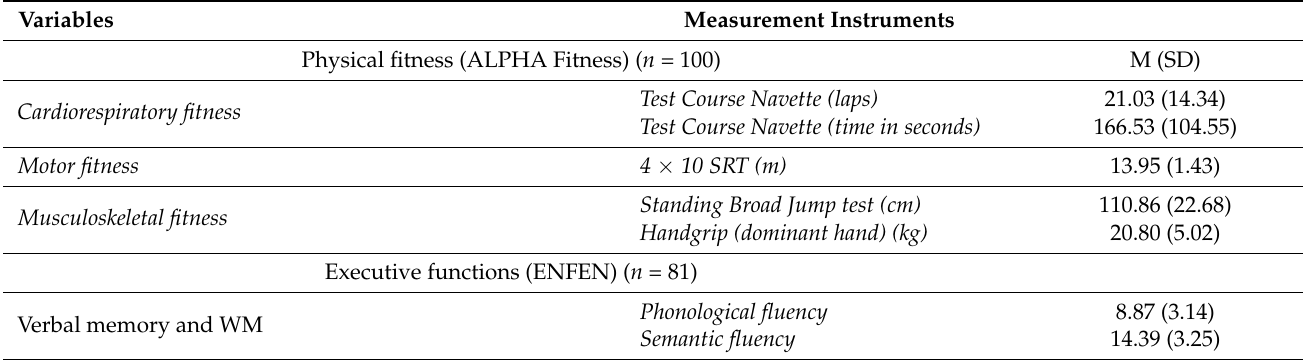
Table 2. Scores obtained on the physical fitness ALPHA test and the ENFEN